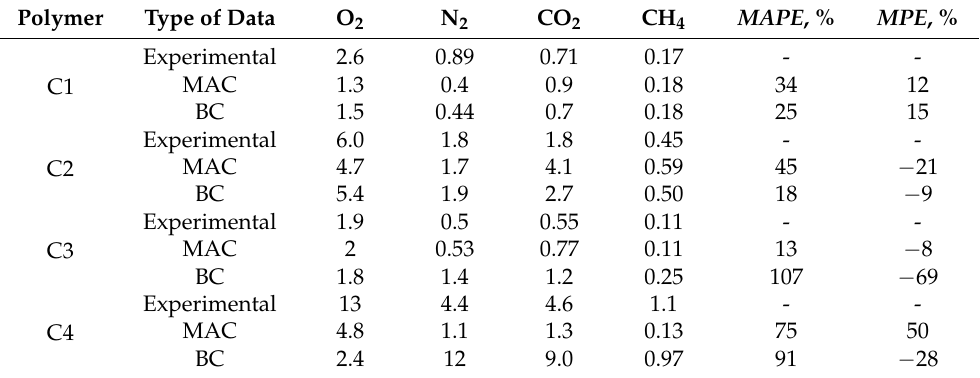
Table 8. Experimental gas diffusion coefficients D · 10 8 (cm 2 · s − 1 ) in synthesized polymers at 35 ◦ C and predicted data for the same polymers. Polymer Type of